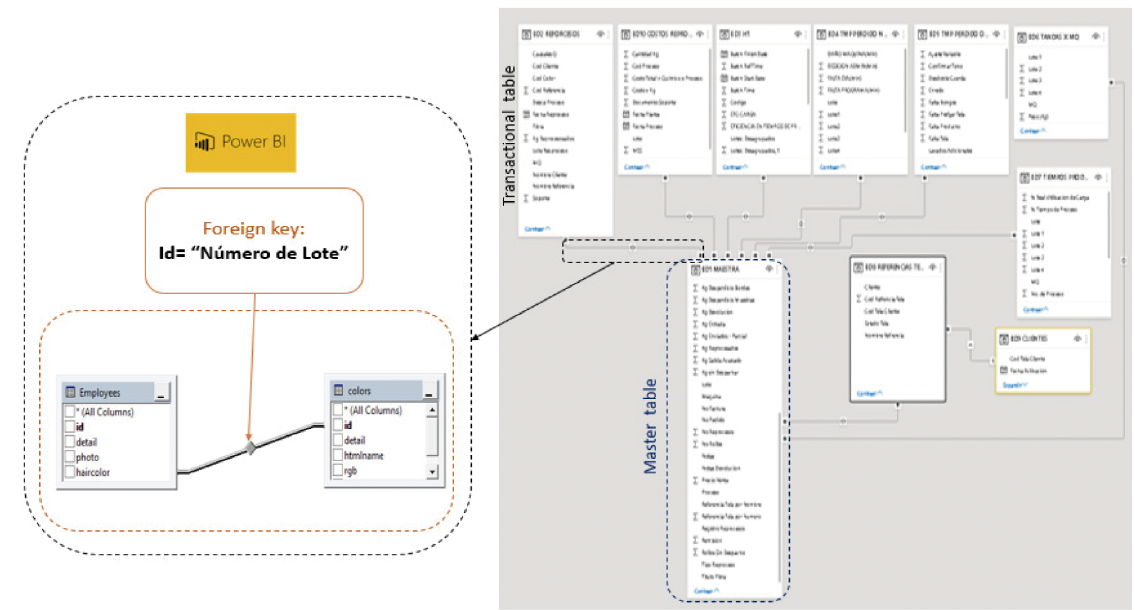
Figure 5. Related databases example in Power BI